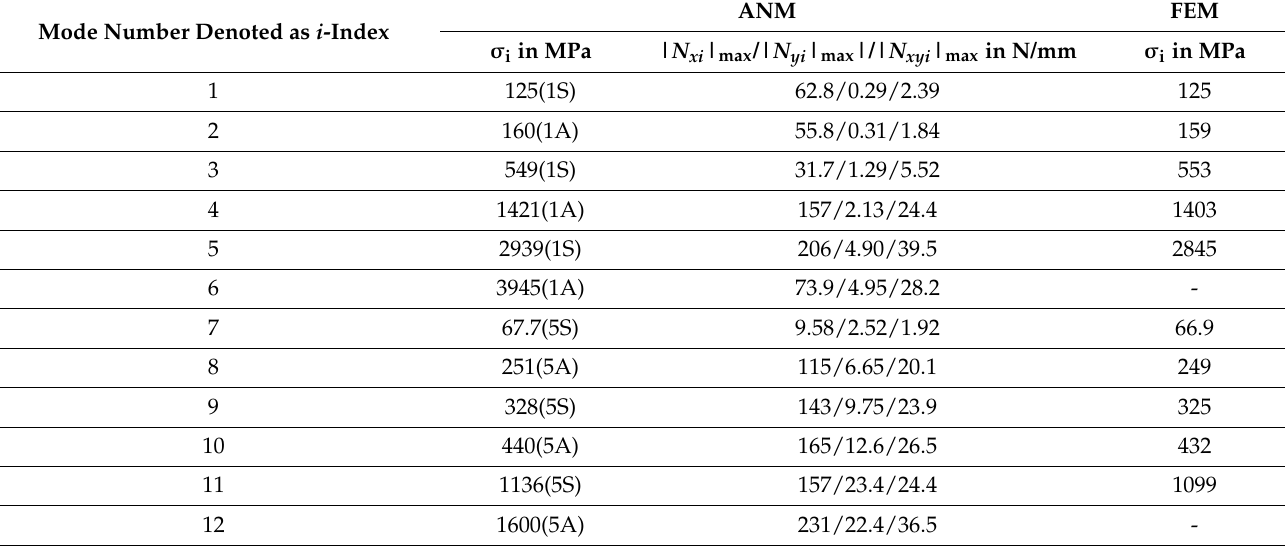
Table 7. Values of bifurcational stresses and maximal absolute membrane forces for the TH-channel of total length 330 mm. ANM and FEM results.